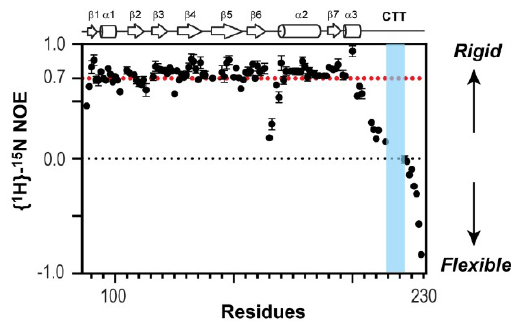
Figure 3. Nuclear magnetic resonance (NMR) { 1 H}- 15 N heteronuclear Overhauser e ff ect (NOE) of 1918 NS1 ED-CTT . Proline-rich motif (PRM) sequence is shown in blue.